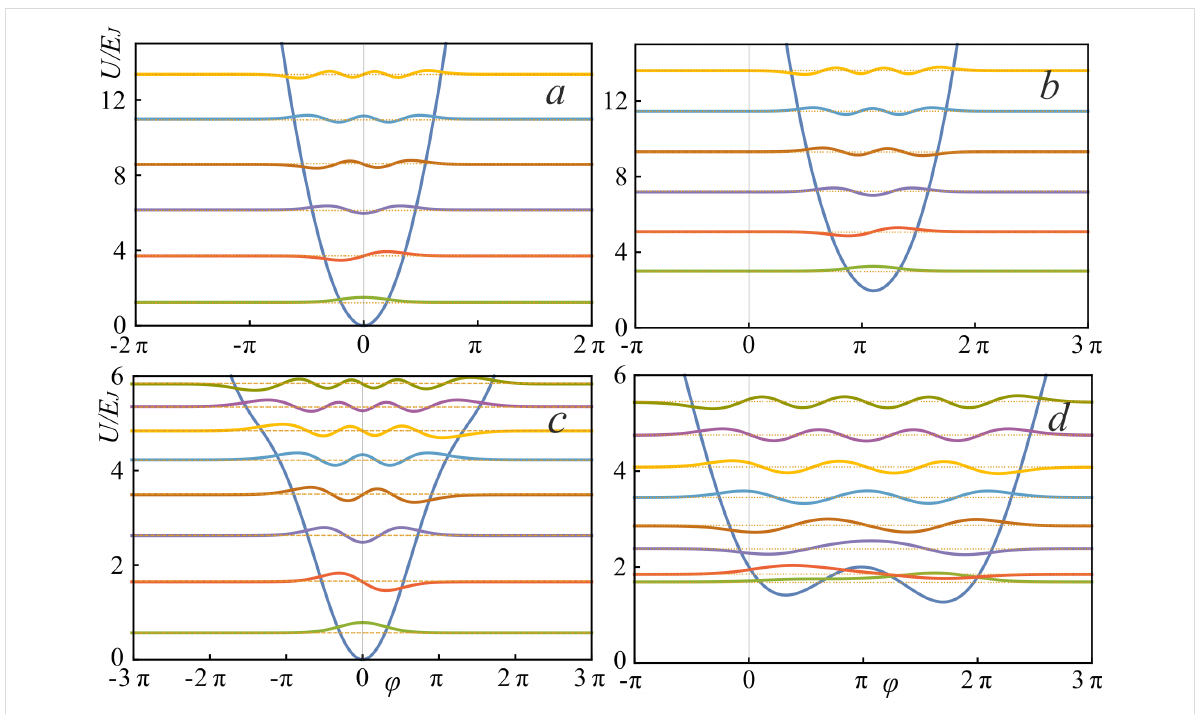
Figure 2: The energy spectrum and adiabatic (instantaneous) wave functions are represented at the initial time t = 0 (a, c) and at the rise of the applied flux, t 1 = 500 (b, d) for the inductance values l = 0.1 (a, b) and l = 2.5 (c, d). The parameters of the system and the input magnetic flux are: E C = 0.5 E J , l a = l + 1, l out = 0.1, D = 0.008, A = 4 π